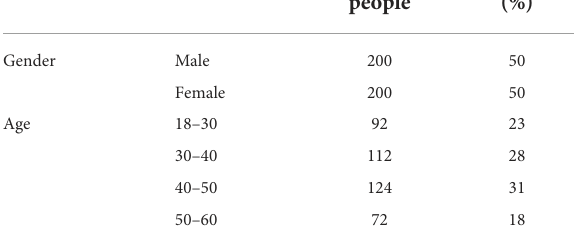
TABLE 2 Questionnaire survey